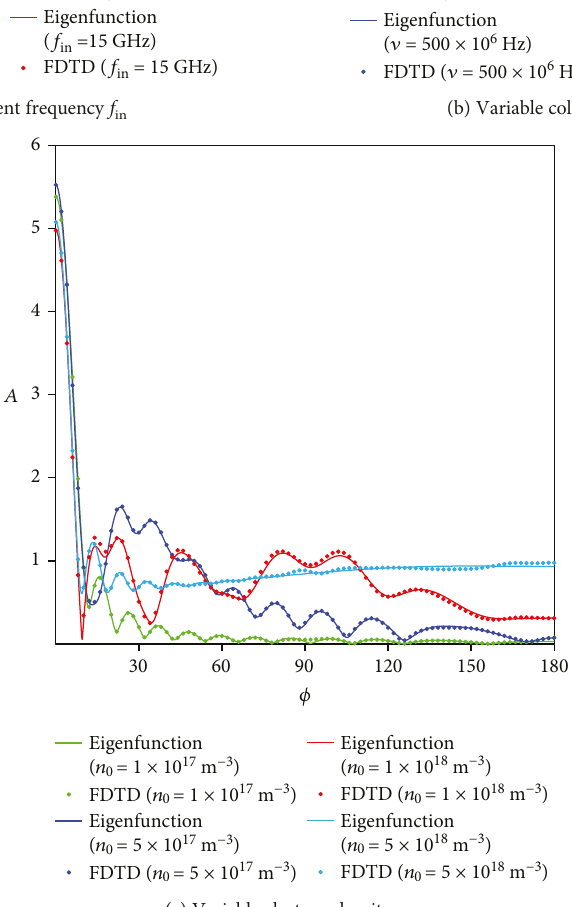
Figure 12: Comparison between the scattering amplitudes obtained by the eigenfunction method and the FDTD simulation for di ff erent variable parameters of the homogeneous